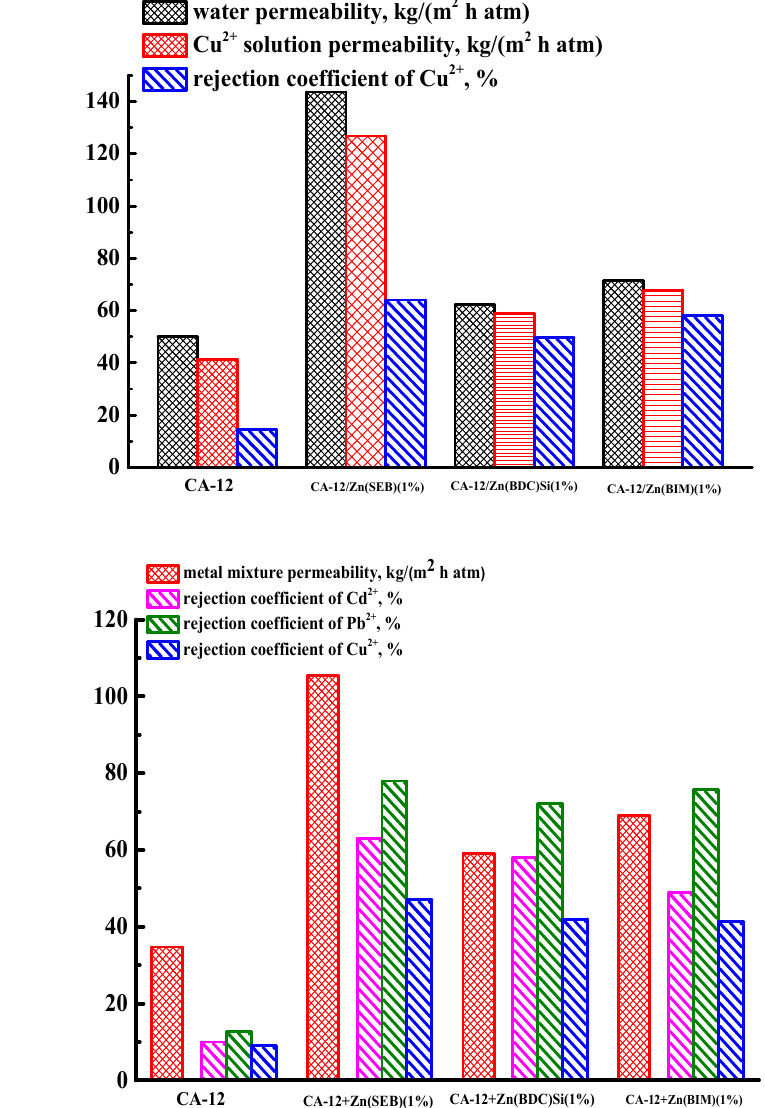
Figure 2. Transport properties of CA-12 and CA-12/Zn-based MOFs (Zn(SEB), Zn(BDC)Si, Zn(BIM)) membranes in nanofiltration of ( a ) water and model Cu 2+ solution, and ( b ) a model solution of heavy metal ions (Cd 2+ , Pb 2+ , Cu 2+ ).